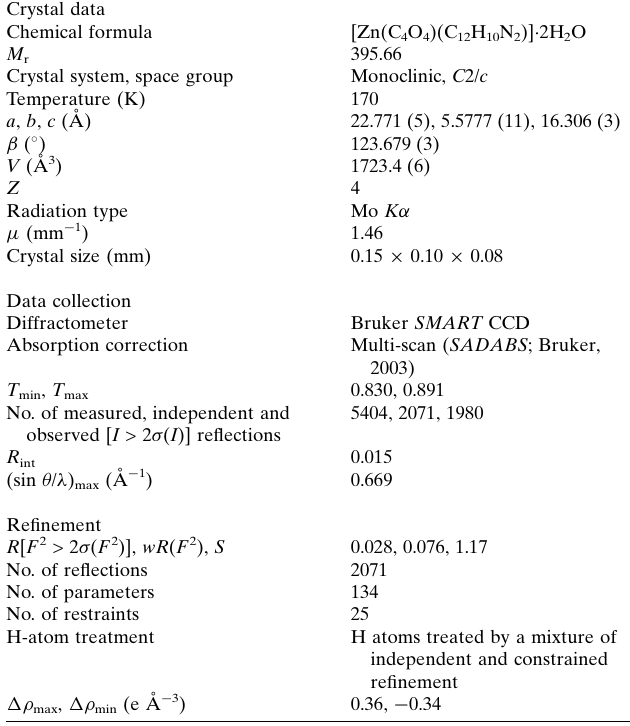
Table 2 Experimental details. Crystal data Chemical formula